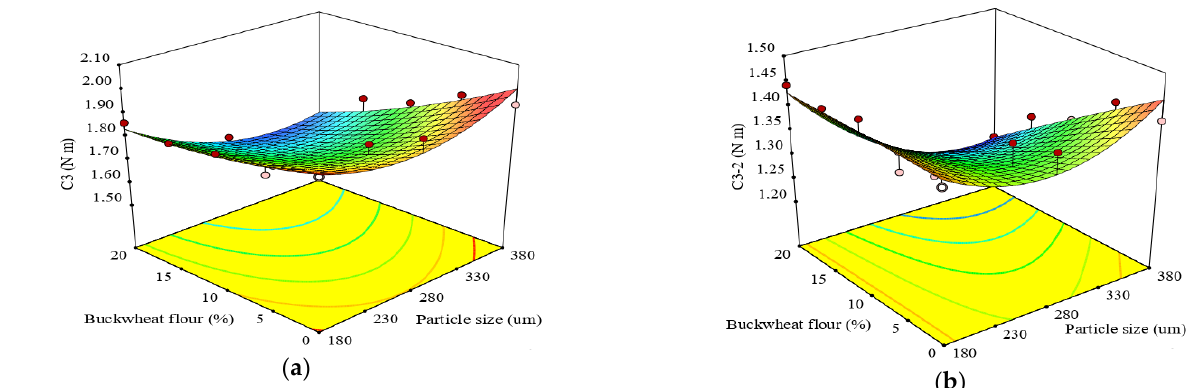
Figure 3. 3D response surface plots showing interaction between buckwheat flour particle size and addition level on ( a ) C3 torque (C3) and ( b ) difference between torques C3 and C2 (C3-2) during starch gelatinization.